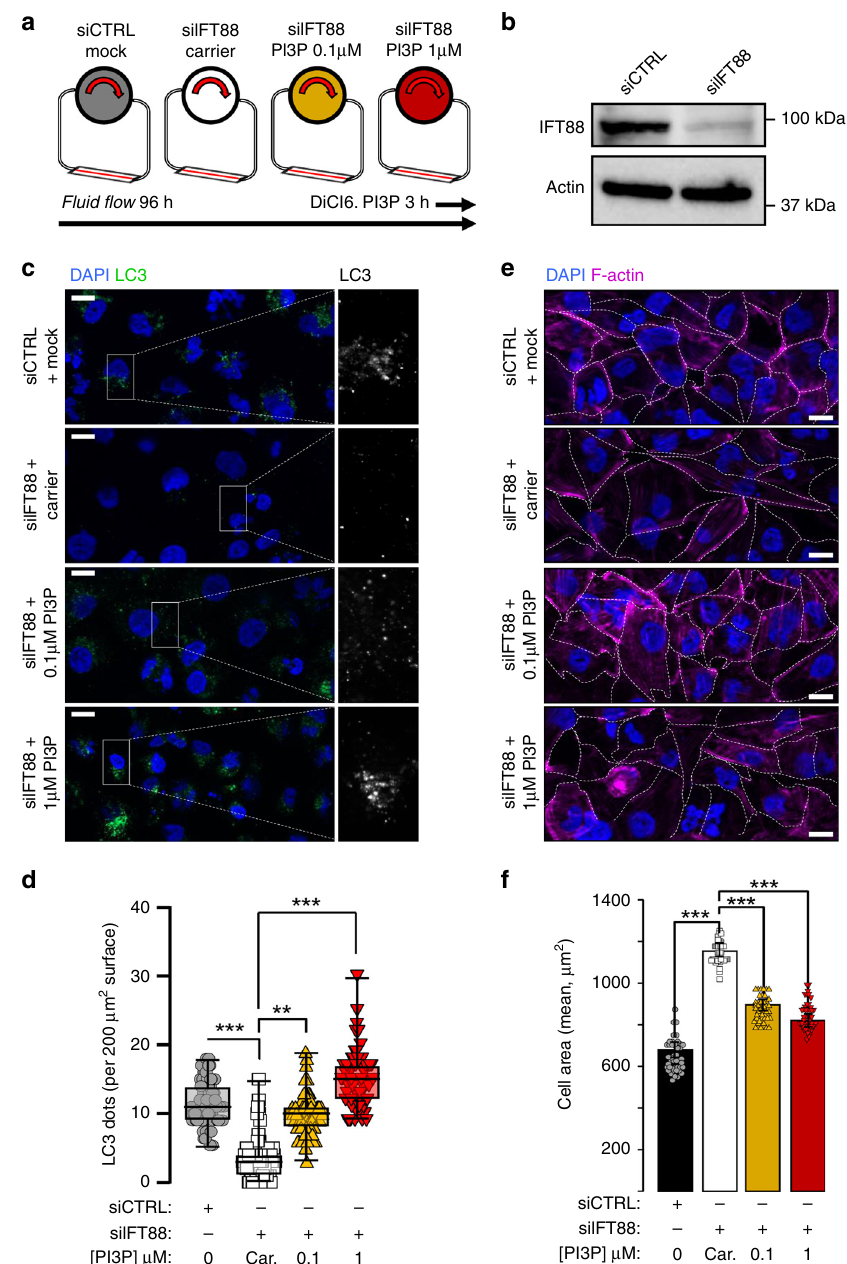
Fig. 4 Exogenous PI3P delivery restores autophagy and cell size regulation upon shear stress in PC-deprived cells. a Schematic display of the experimental design; all cells were analyzed after 96 h of fl uid fl ow. We added to IFT88 knockdown (siIFT88) HK2 cells cells two different concentrations of exogenous PI3P (DiCI6.PI3P, in lipid carrier vehicle, at 0.1 and 1 μ M) during the last 3 h of fl uid- fl ow treatment and compared them to control cells (siCTRL) and to siIFT88 cells added with carrier alone, as a negative control. b Western blot analysis of IFT88 in lysates of HK2 cells (siCTRL) and IFT88 knocked down cells (siIFT88). c , e Representative confocal images of HK2 cells (siCTRL), compared to siIFT88, supplemented with exogenous PI3P (0.1 and 1 μ M) or with carrier only, upon shear-stress (96 h) conditions, immunostained for LC3 and DAPI or F-actin and DAPI, respectively. Scale bar, 10 μ m. d , f Quanti fi cations of c and e . Bar graphs denote average number of LC3 puncta per 200 µ m 2 area and average cell surface, respectively (mean ± SEM, N = 70, from three independent experiments). ** p < 0.01, *** p < 0.001 in two-tailed Student ’ s t